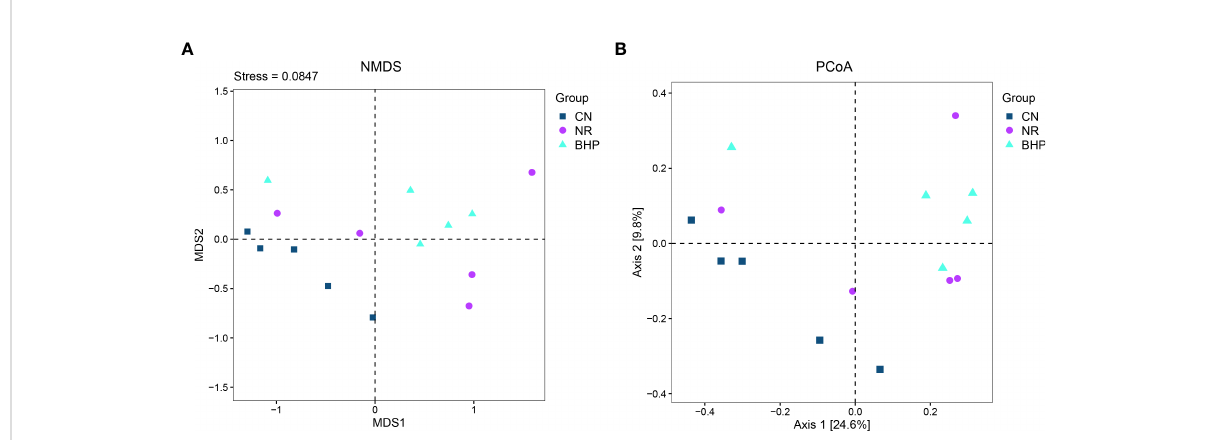
FIGURE 6 Beta diversity of the lactase-producing bacteria from the intestinal contents in each group. (A) NMDS (Based on Jaccard distance). (B) PCoA (Based on Jaccard distance). By PERMANOVA test, the community structure of the NR was signi fi cantly different from CN and BHP ( P < 0.05), and the community structure of the CN was not signi fi cant difference from BHP (P > 0.05). In the graph, each point represents a sample, and samples of the same color are from the same group. The greater the difference between every two points, the greater the difference between